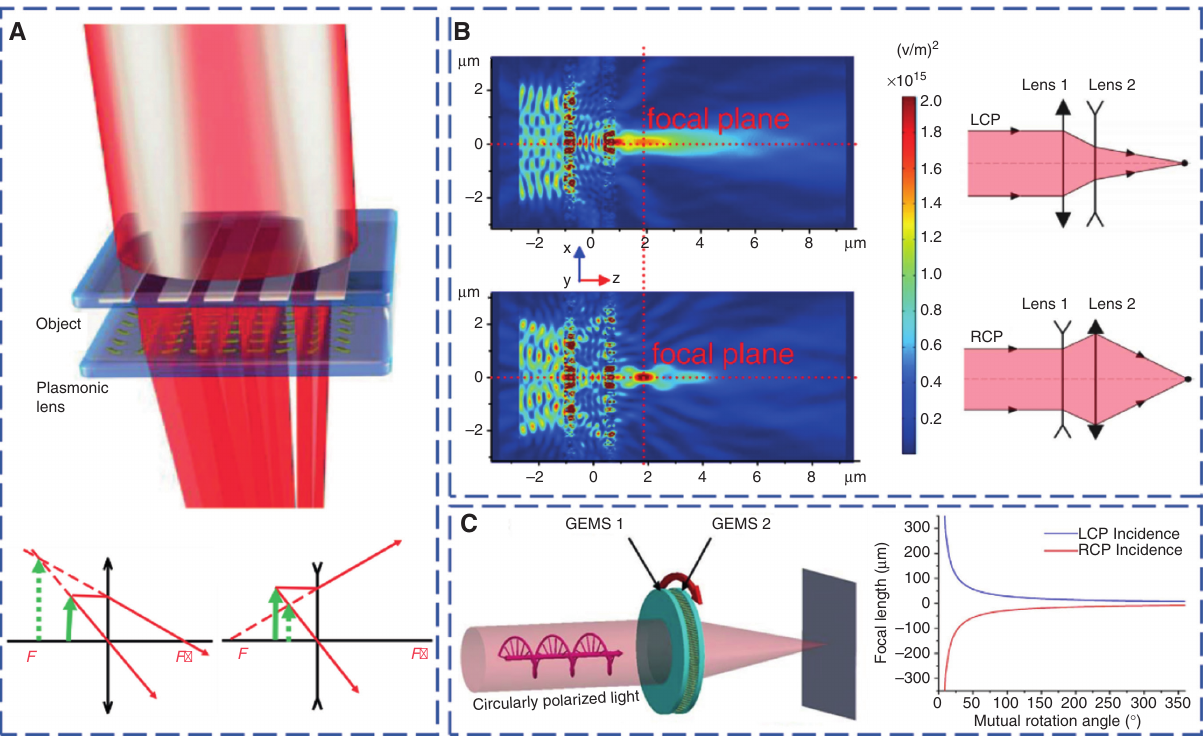
Figure 10: Multifunctional GEMS with helicity control. (A) Metasurfaces acting as both positive and negative lenses [83]. (B) Dual FOV step-zoom metalens [84]. (C) Continuous-zoom metalens conducted with Moire effect [85]. Reprint permission obtained from